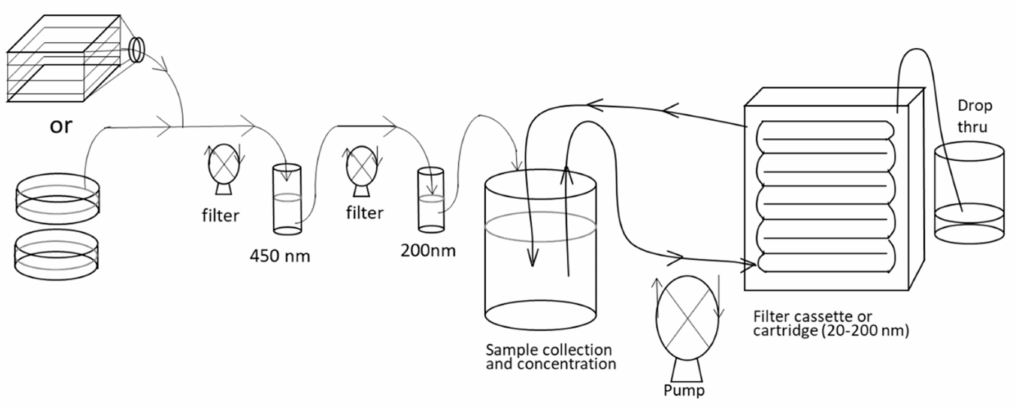
Figure 8. Isolation of UCMSC